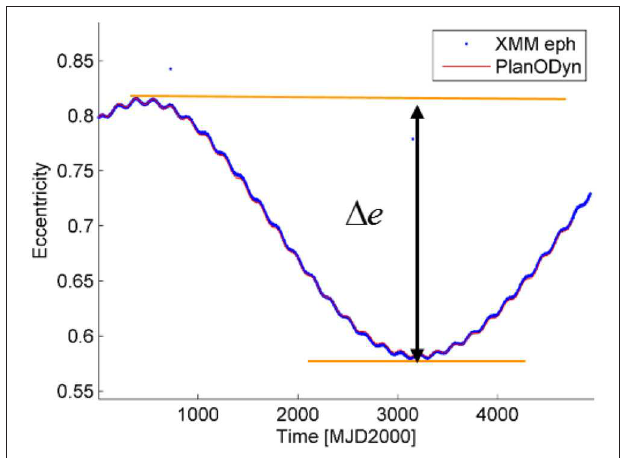
FIGURE 4 | XMM-Newton orbit evolution and minimum and maximum eccentricity attained during the motion evolution. Blue line: actual ephemerides, red line: propagation with